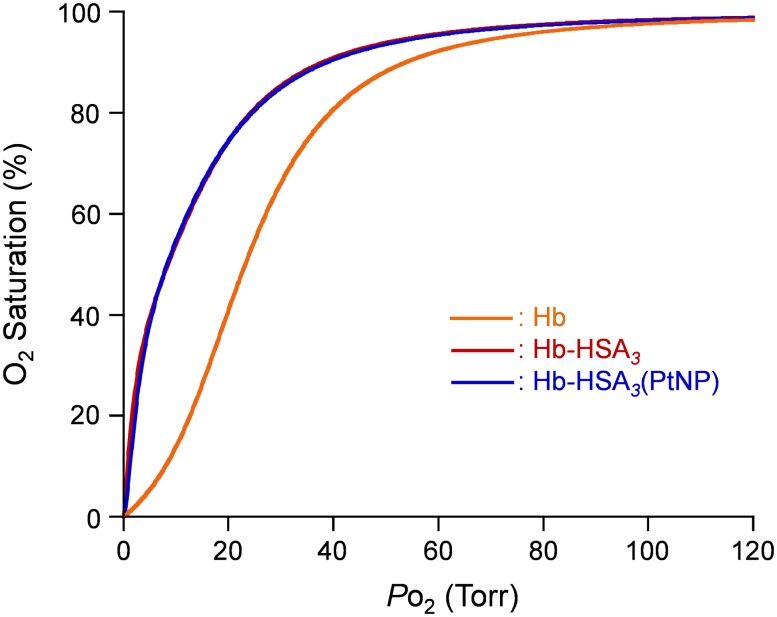
O2 equilibrium curves of Hb-HSA3 and Hb-HSA3(PtNP) clusters.In PBS solution (pH 7.4) at 37°C.